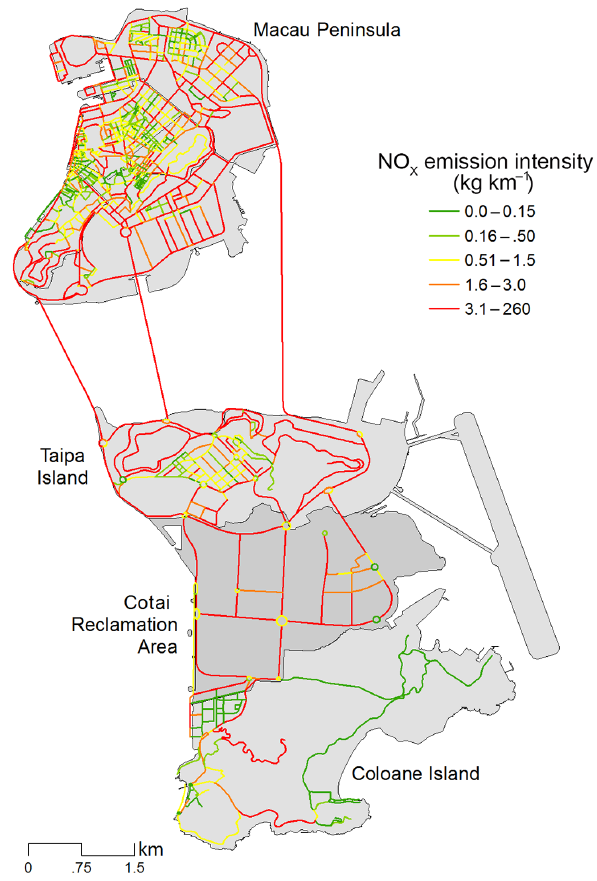
Figure 6. The spatial distribution of NO x emission intensity for on- road vehicles in Macau on a typical weekday in 2010.